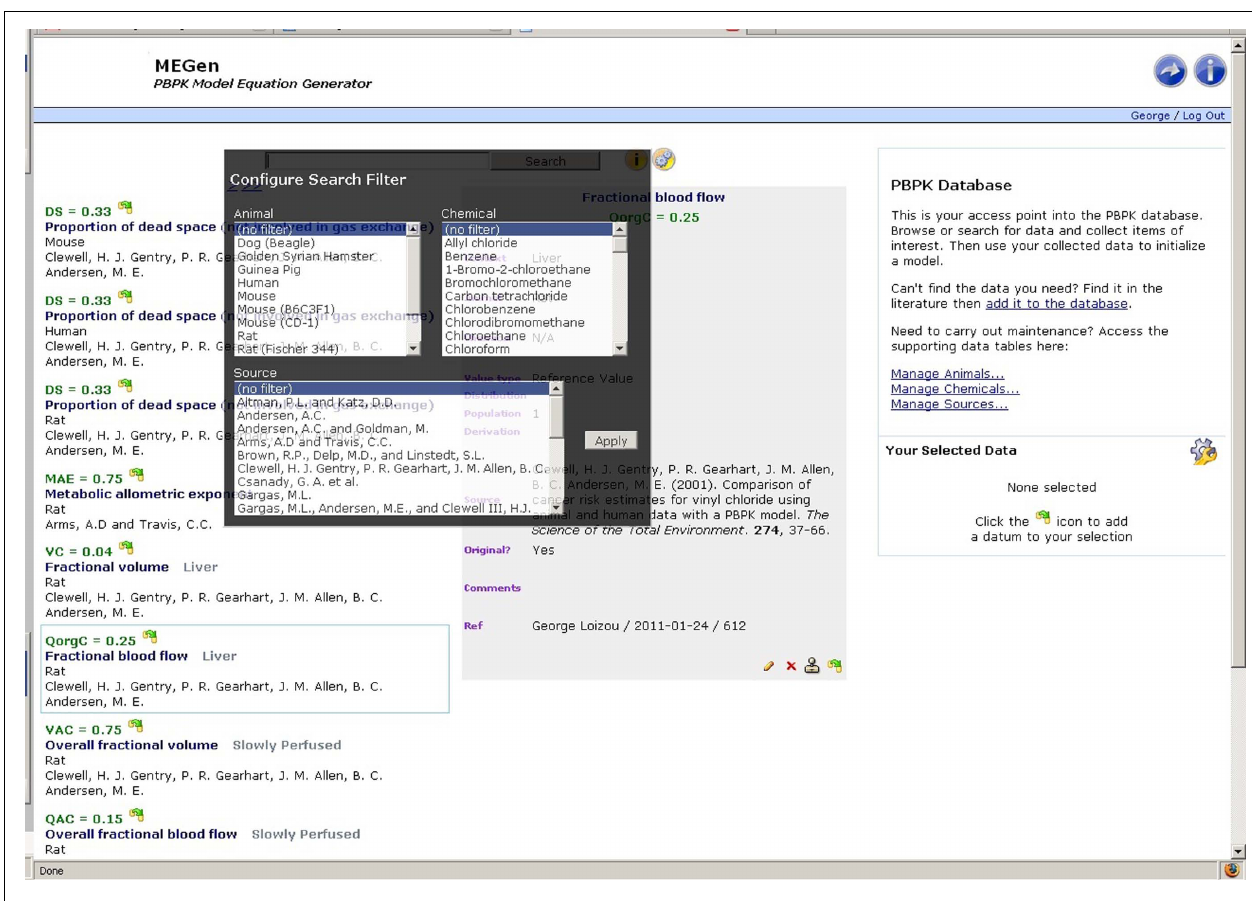
FIGURE 3 | Database search page: application of